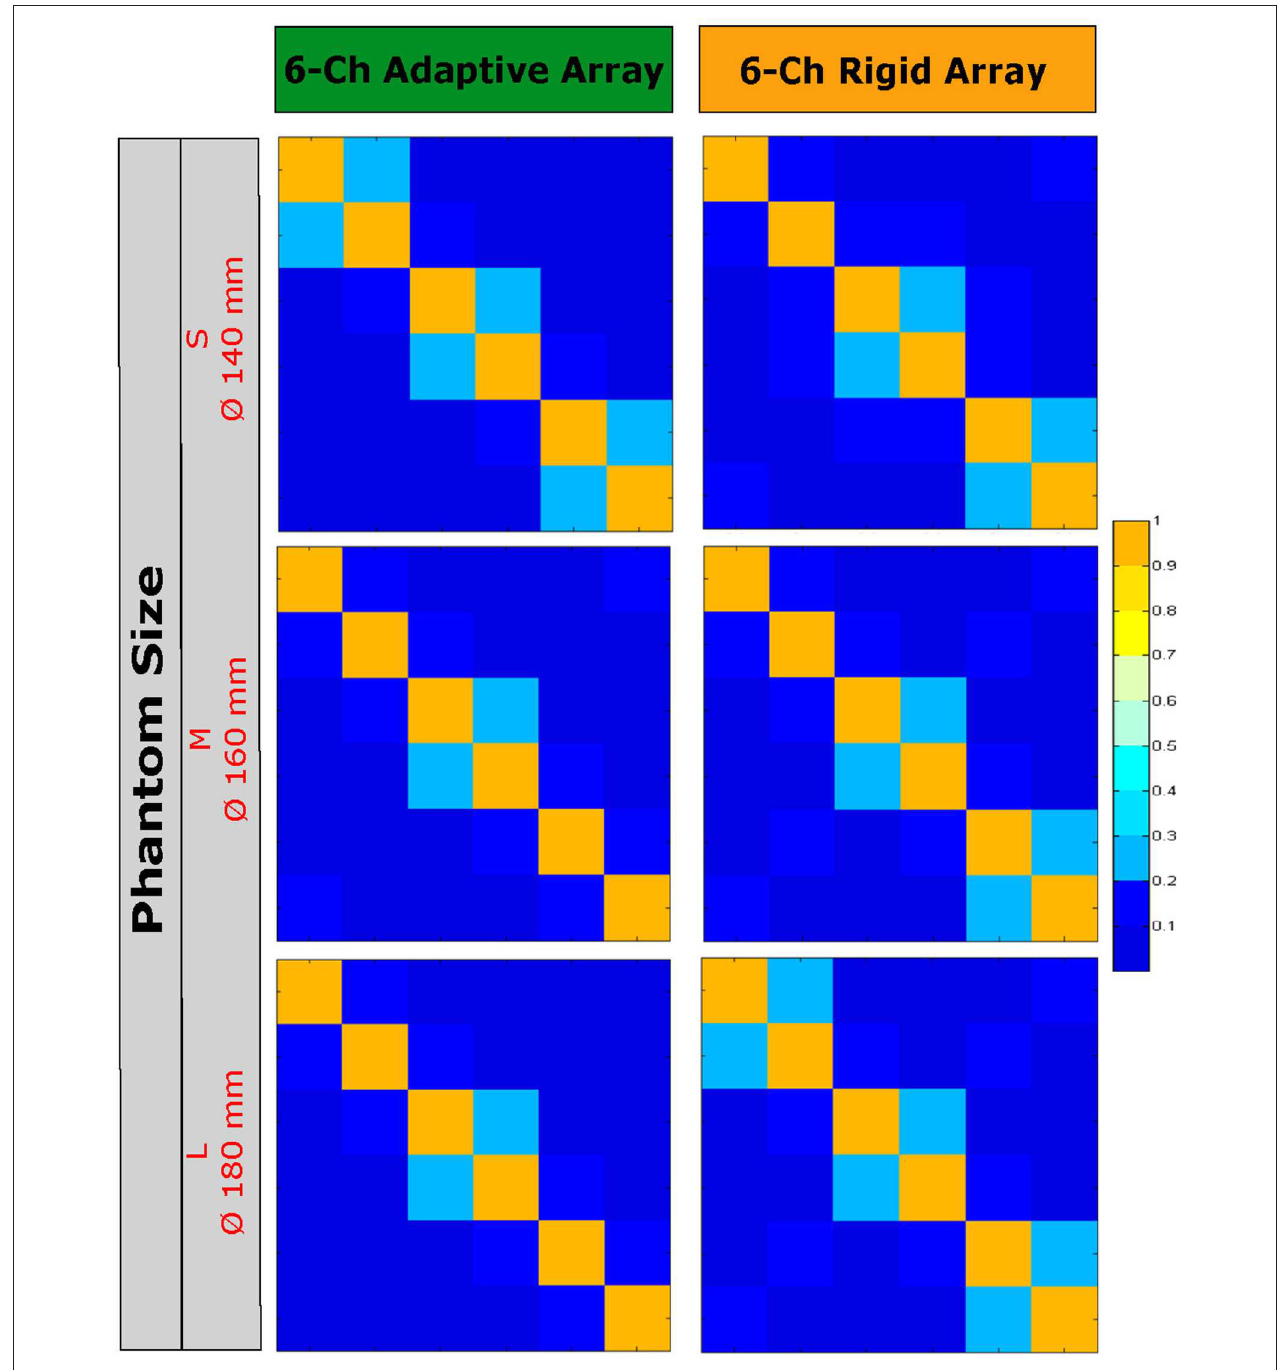
FIGURE 10 | Noise Correlation Images of the adaptive and the rigid knee array on the three different